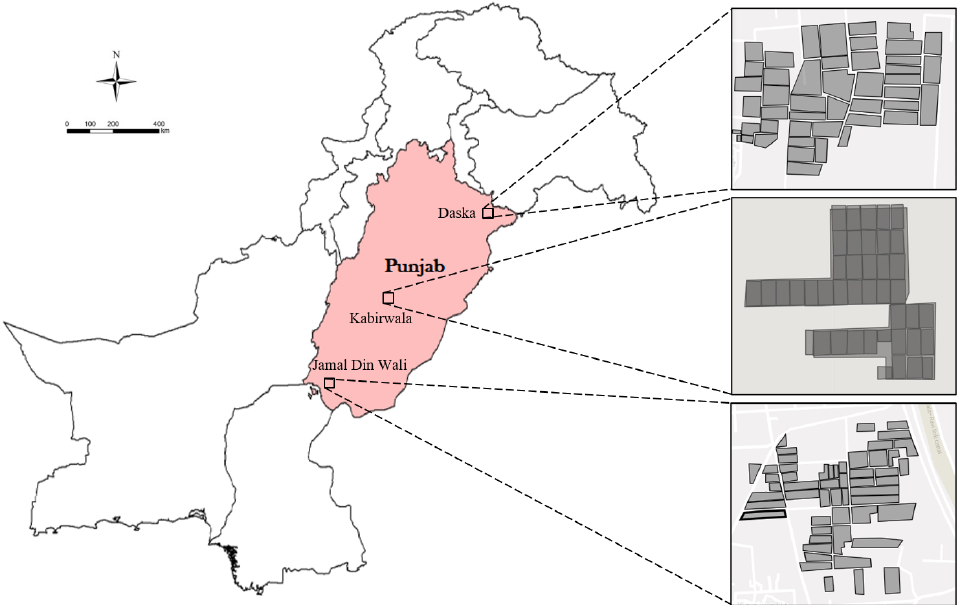
Figure 1. Map of the Province Punjab, Pakistan. The images of the fields of interest are acquired at a resolution ranging from 10m to 60m depending on the bands of Sentinel-2